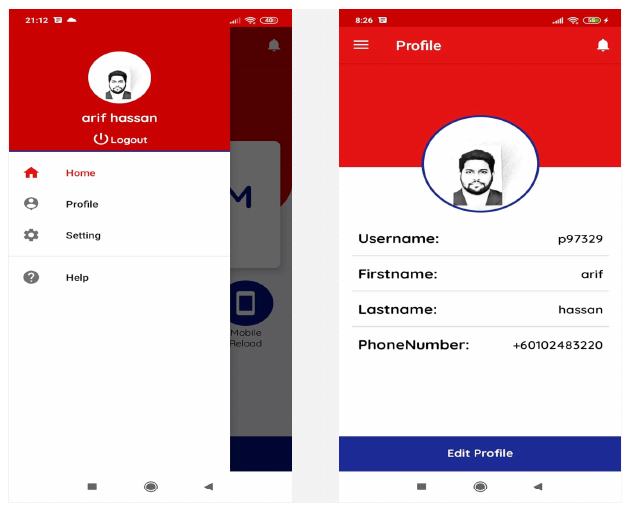
Figure 13. Profile page and dashboard activity of Zamwallet.